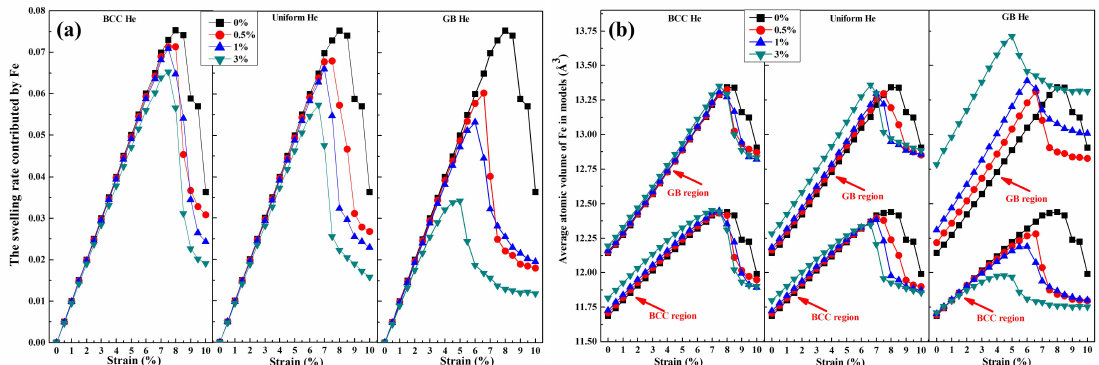
Figure 11. ( a ) Swelling rate contributed by Fe, and ( b ) average atomic volume of Fe in BCC and GB region. Atomic volume of Fe which surround the crack is set as 16 Å 3 , in order to deduct the space took up by the